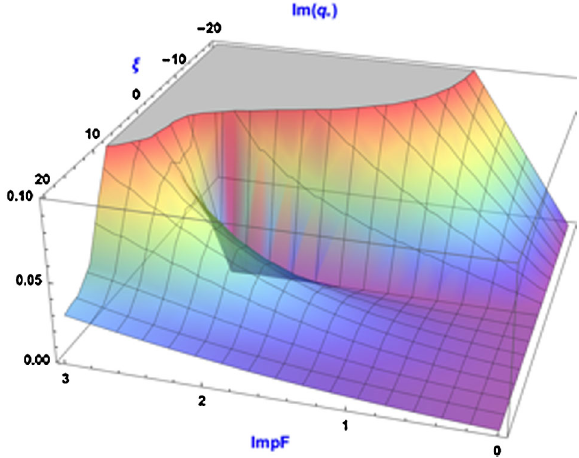
FIG. 27. Single bunch growth rate for the resistive damper and TMCI threshold intensity ImpF ¼ 2 . 4 . Note that the lake of stability (shown upside down) almost